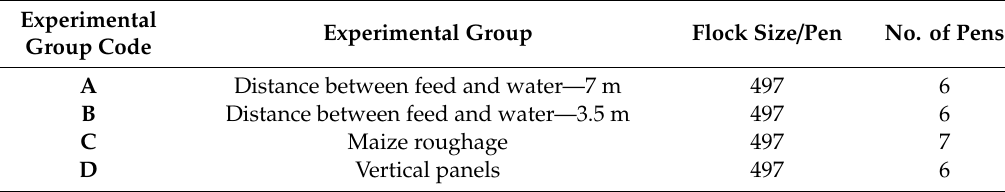
Table 1. Experimental groups, flock size / pen and total number of pens for each enrichment across all six